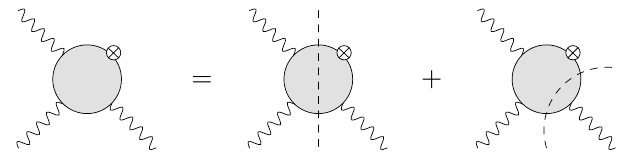
Figure 1 . Unitarity cuts contributing to the discontinuity of HLbL with respect to q 2 kinematics. The static external electromagnetic field is denoted by a crossed circle.